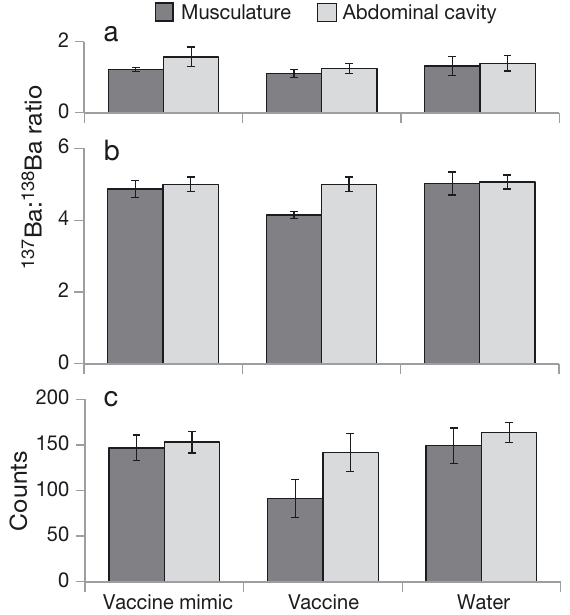
Fig. 4. Salmo salar . Strength of mark uptake with 137 Ba en- richment. Bar graphs show: (a) average ratio, (b) maximum ratio for scans above detection limit, and (c) number of scans above detection limit. Error bars represent ±1 SE